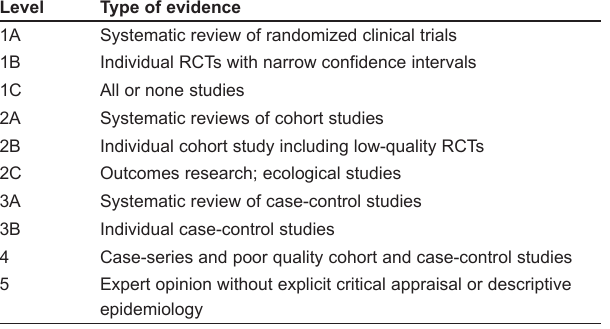
TABLE 2 Oxford system for grading level of evidence Level